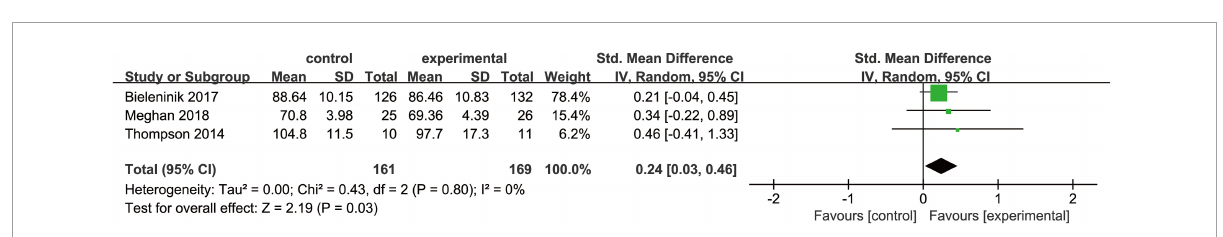
FIGURE4 Forest plots of of MT (vs. no-MT) effect on the SRS score; SD: standard deviation; 95% CI: 95% confidence interval; IV: inverse variance method.